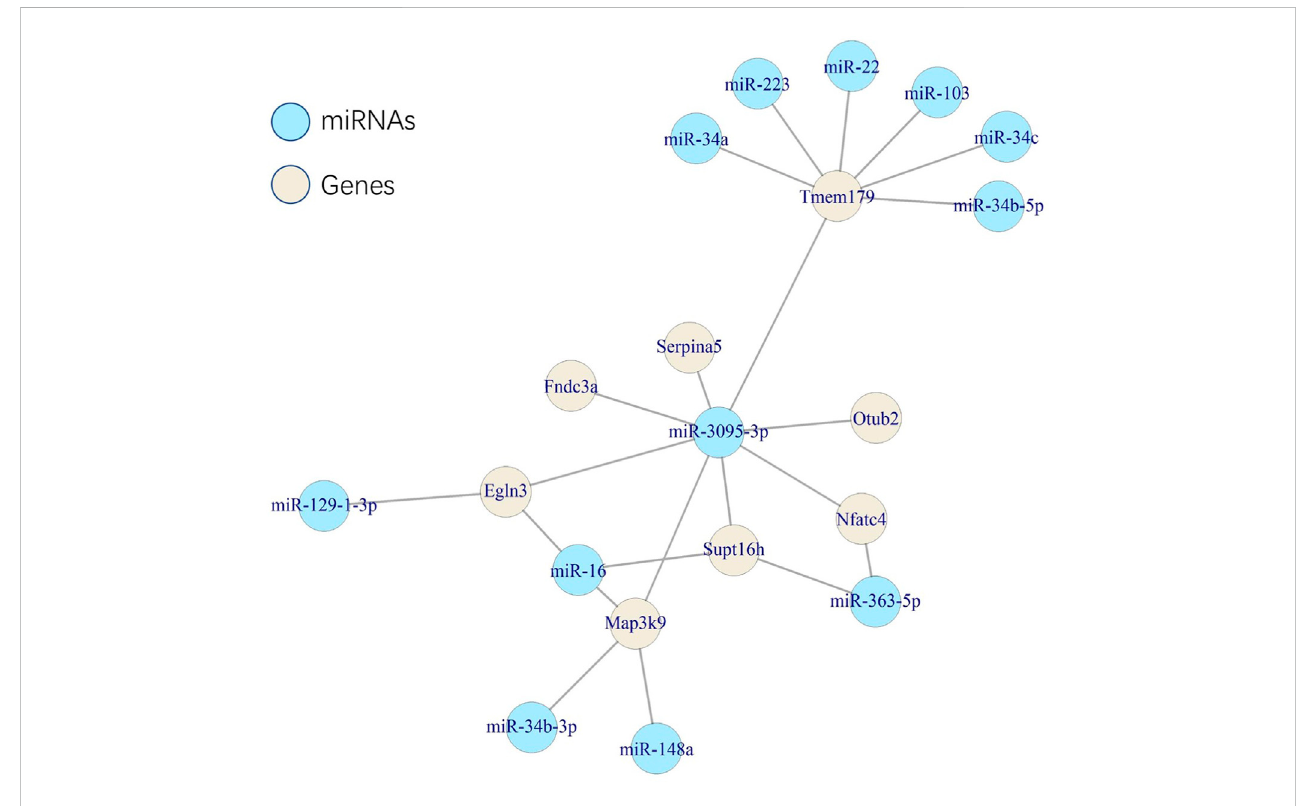
FIGURE 7 Network of the associations among microRNAs and